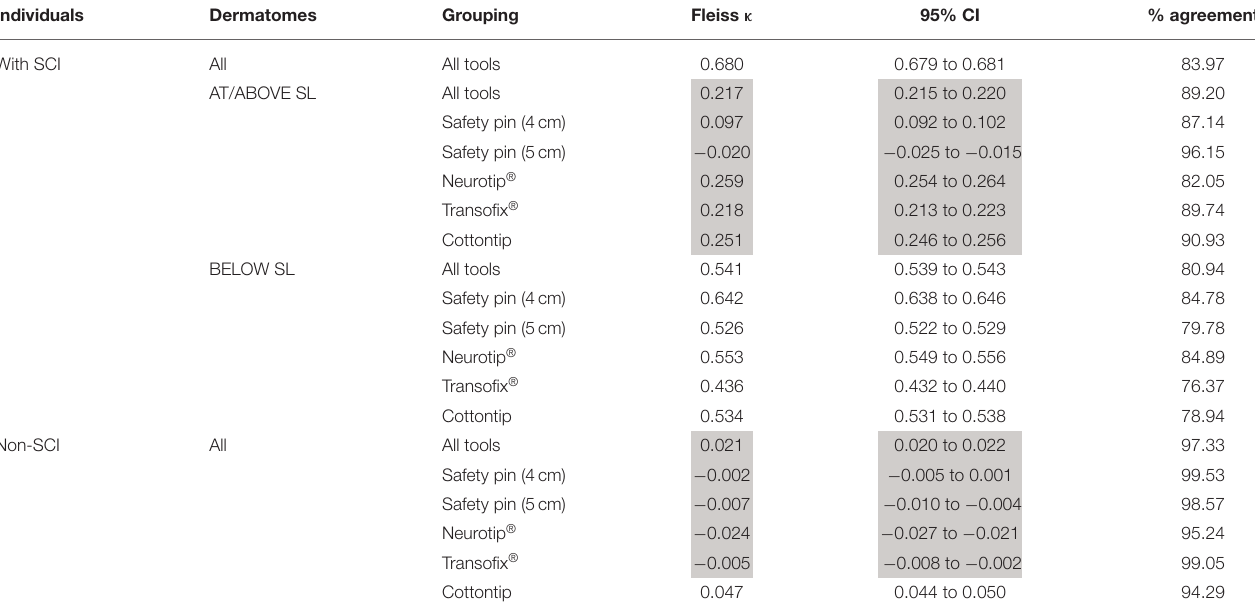
TABLE 2 | Interrater reliability for three raters in individuals with and without spinal cord injury considering the sensory level and the applied tool. Individuals With